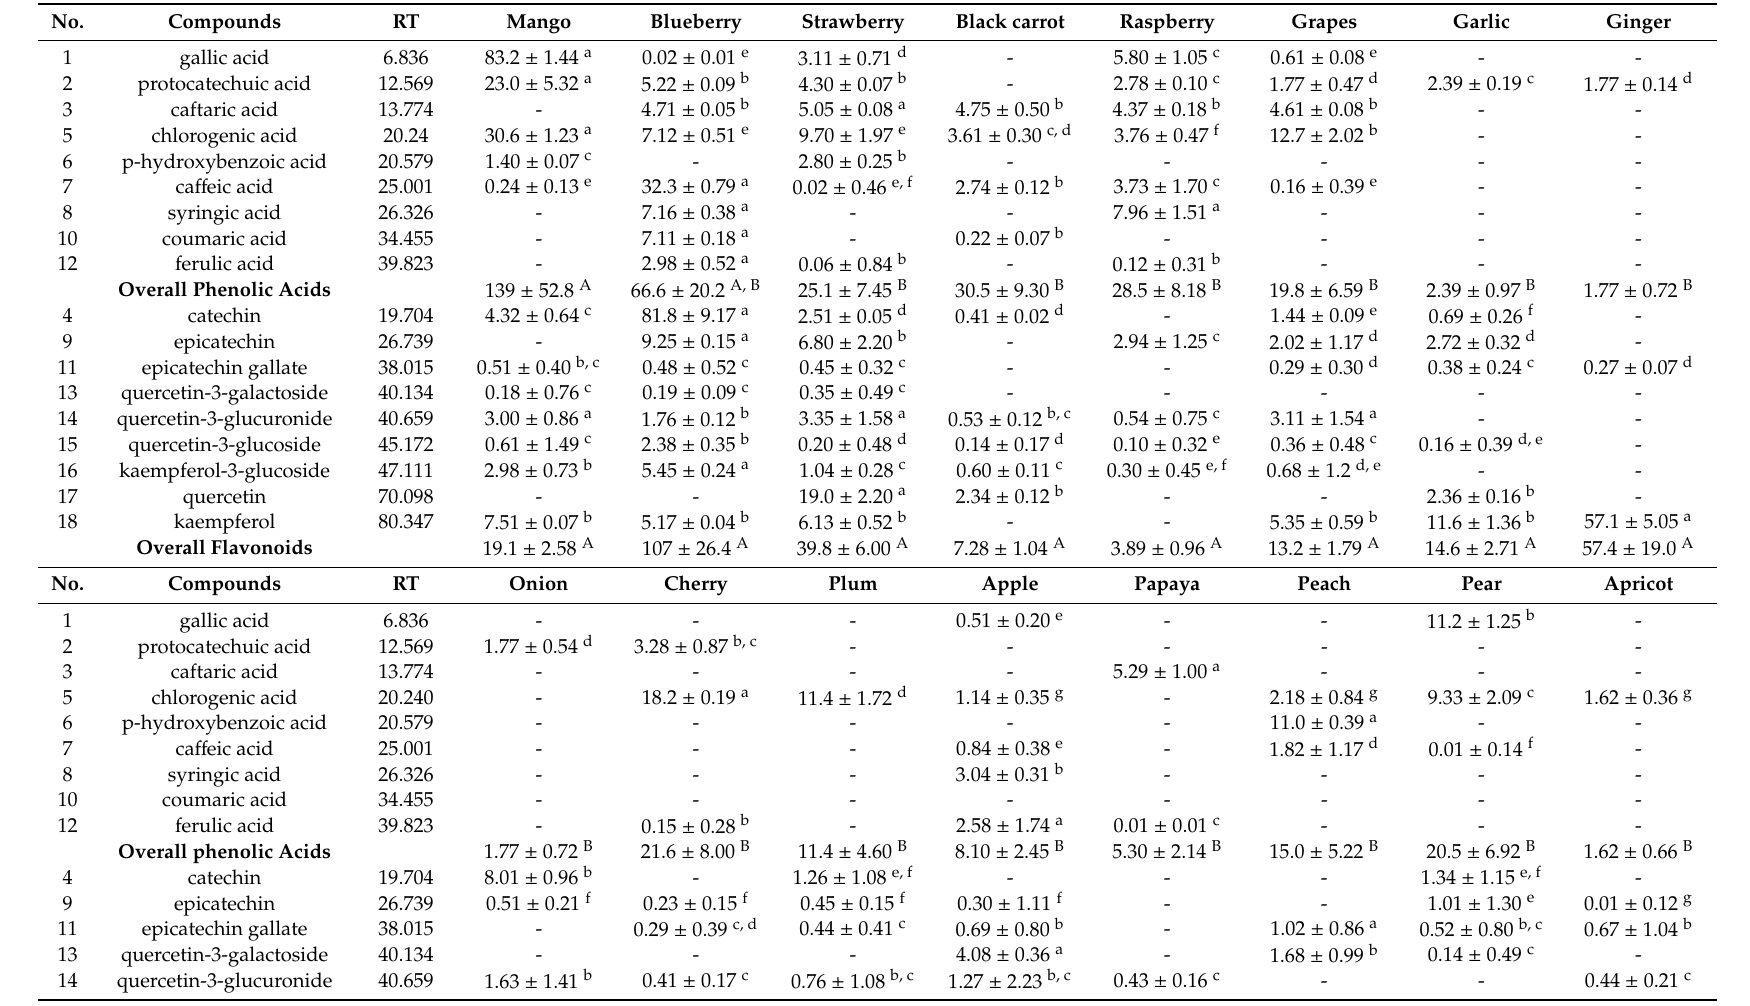
Table 2. Polyphenolic contents of di ff erent fruits and vegetables quantified using